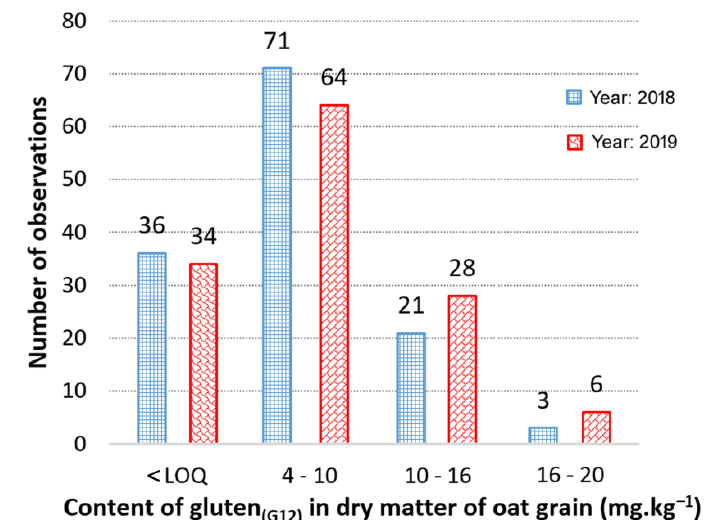
Figure 1. Year distribution of detected average content of cross-reactive avenin peptides (Gluten G12 ) in the set of 132 oat cultivars. Note: The detected mean value 309.4 ppm of Sirene cultivar from 2018 was not included.